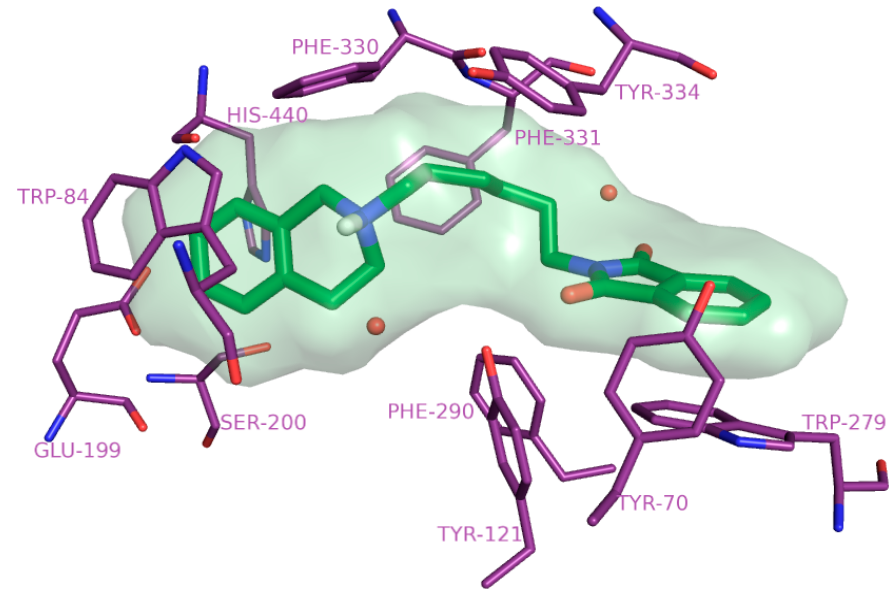
Figure 4. The binding mode of compound 11 (green) within the active site of AChE.